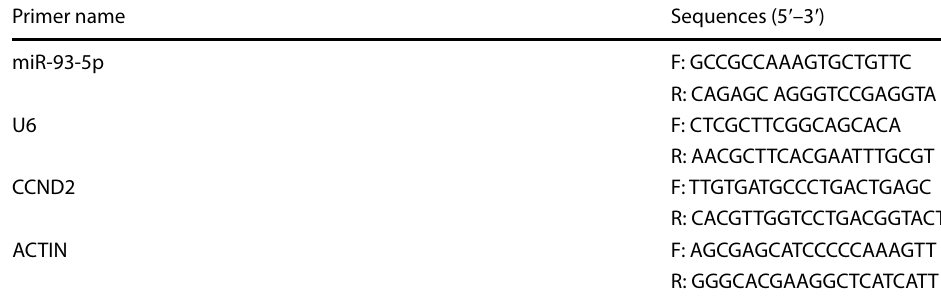
Table 1 Primer sequences used for